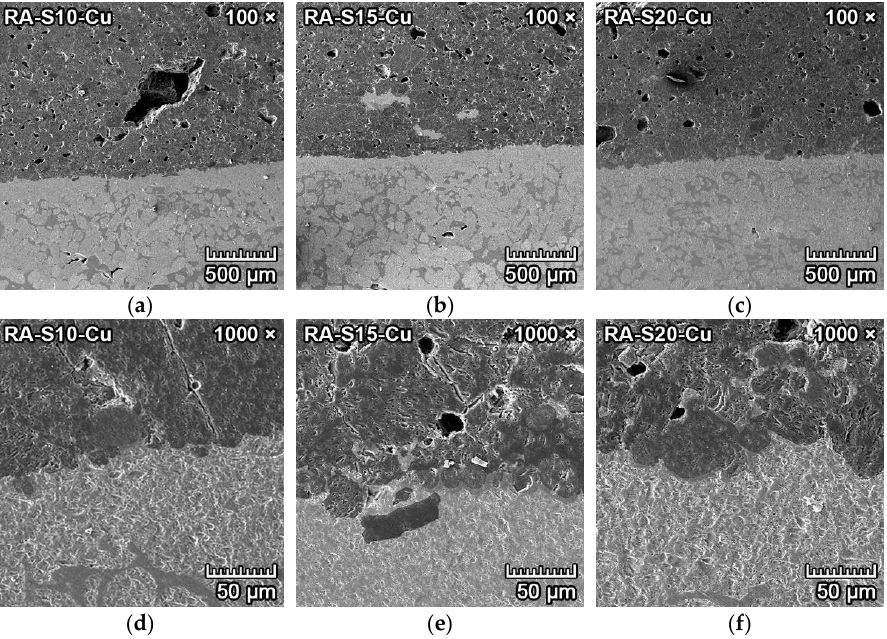
Figure 13. SEM microstructure of the transition zone between copper (light grey and smooth) and forsterite–spinel ceramics (darker and porous) of reactive alumina–based mixtures FA-S10, FA-S15 and FA-S20, with a magnification of 100× ( a – c ) and a magnification of 1000× ( d – f ).